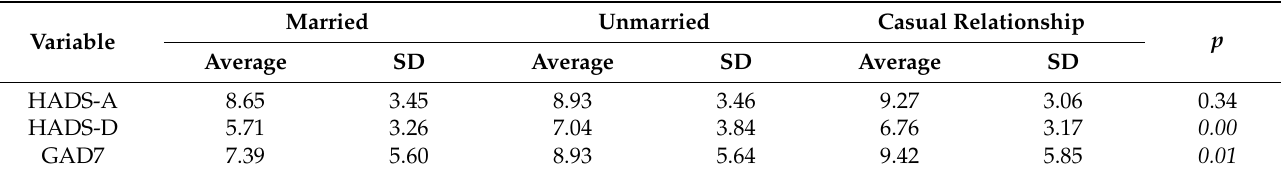
Table 3. Comparison of HADS and GAD-7 scale values by marital status.